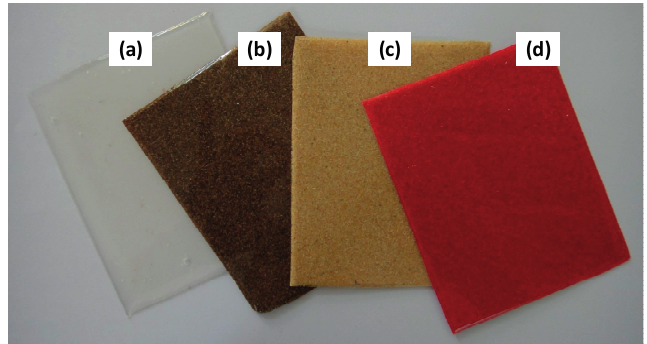
Figure 5. Image of ( a ) neat poly(lactic acid) (PLA); ( b ) PLA/UTF30; ( c ) PLA/BF30 and ( d ) PLA/masterbatch (MB)/BF30 composites.